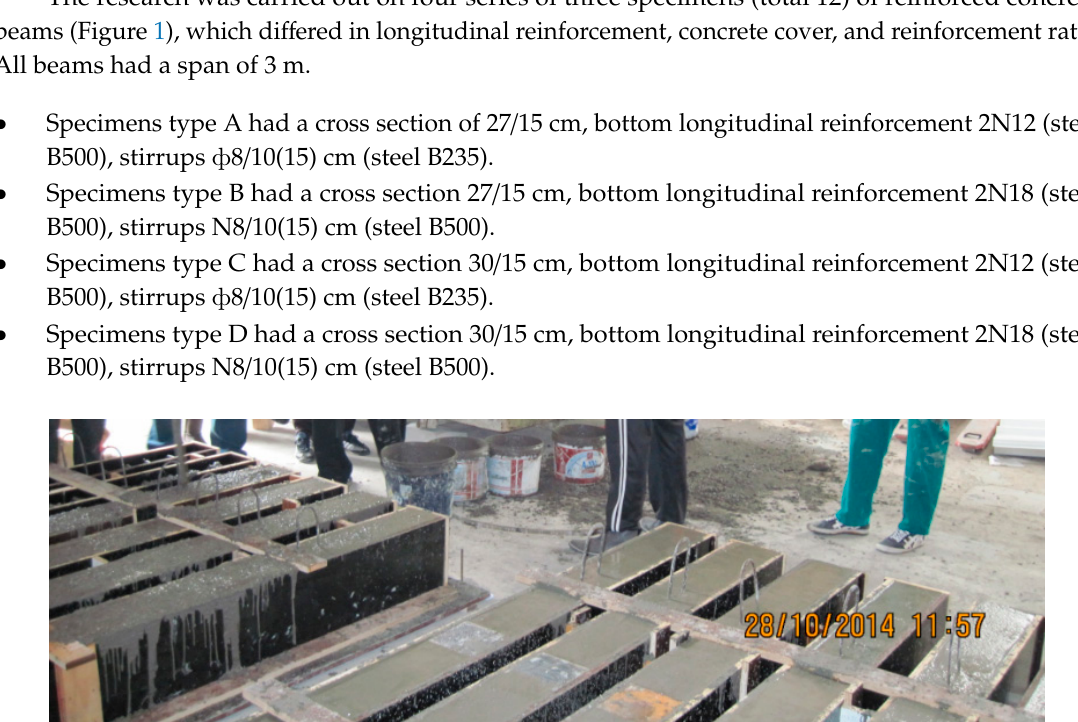
Figure 1. The 12 tested beams preparation (personal archive).